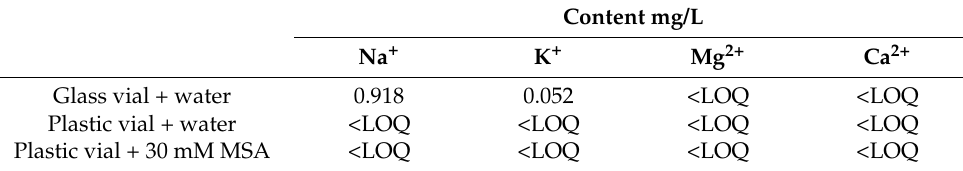
Table 3. Blanks in different materials.